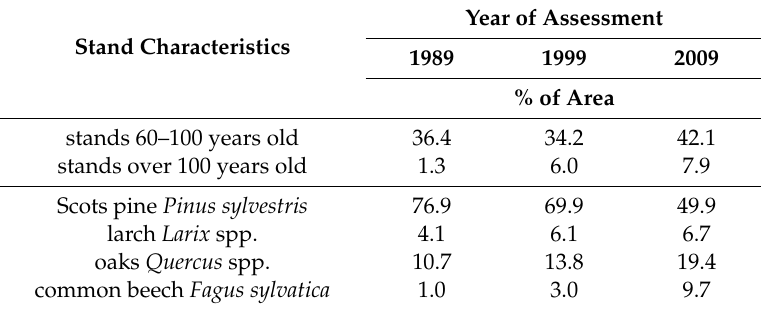
Figure 1. The distribution of forest complexes in the study area (central Poland, vicinity of Rogów village, Experimental Forest Station of Warsaw University of Life Sciences): Approximate borders of the whole study area for the Northern goshawk inventory and sampling areas for the monitoring of magpie, hooded crow, pheasant, and grey partridge are shown. Table 1. The changes in the structure of stands in the study area (central Poland, vicinity of Rogów village, Experimental Forest Station of Warsaw University of Life Sciences) in recent decades [34]: The table lists stands that are old enough to place nests by the Northern goshawk and the main trees species available in the current period.